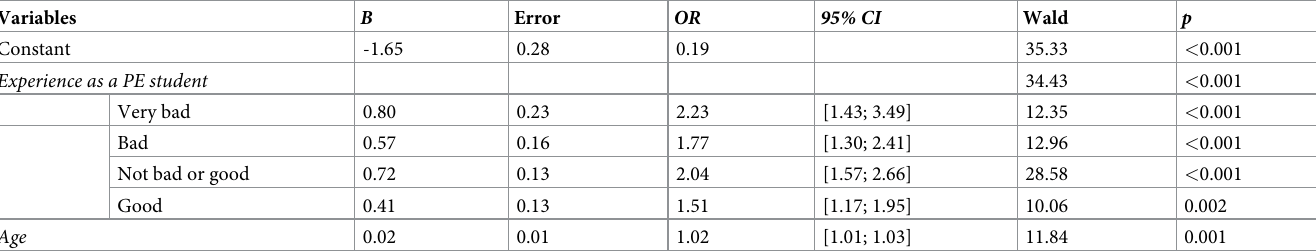
fathers (28.8%), and the same applies to Spanish parents (40.4%) with respect to Portuguese ones (22.6%). Table 2 presents basic descriptive statistics for the parental assessment of past experience as PE student, parents’ support of PE and Parents’ PA. Mothers significantly reported better past experiences as PE student than fathers ( χ 2 = 23.70, p < .01) and the same occurred for Portu- guese parents with respect to Spanish ones ( χ 2 = 23.70, p < .01). When analysing parents’ sup- port of PE no differences were found neither between mothers and fathers ( χ 2 = 1.89, p = .76) nor between nationalities ( χ 2 = 4.14, p = .39). With regard to parents’ PA, no differences were observed between mothers and fathers ( χ 2 = 3.79, p = .05) but Spanish parents were more active than Portuguese ones ( χ 2 = 86.30, p < .01). The multivariate binary logistic regression analysis yielded a final model that included only the main effects of past experience as PE student and age (Table 3). As the past experience as PE student deteriorated and as age increased, there was an increase in the probability that parents evaluate PE as deserving a less important status than the one it currently has in their children’s curriculum (p < 0.01). Neither main effect nor confounding was detected for parents’ PA level so this variable was not retained in the final model. Table 3. Logistic regression model to predict the parental assessment of physical education in the curriculum. (N = 3068). Variables B Error OR 95% CI p Constant -1.65 < 0.001 Experience as a PE student 34.43 < 0.001 Very bad